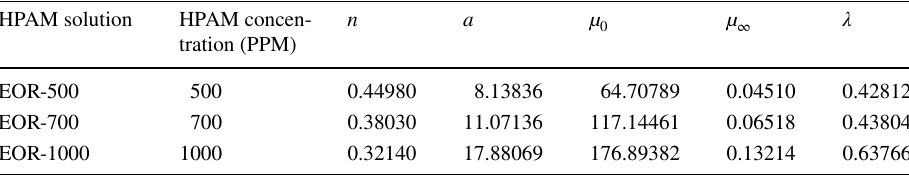
Table 1 Carreau-Yasuda model parameters for the three